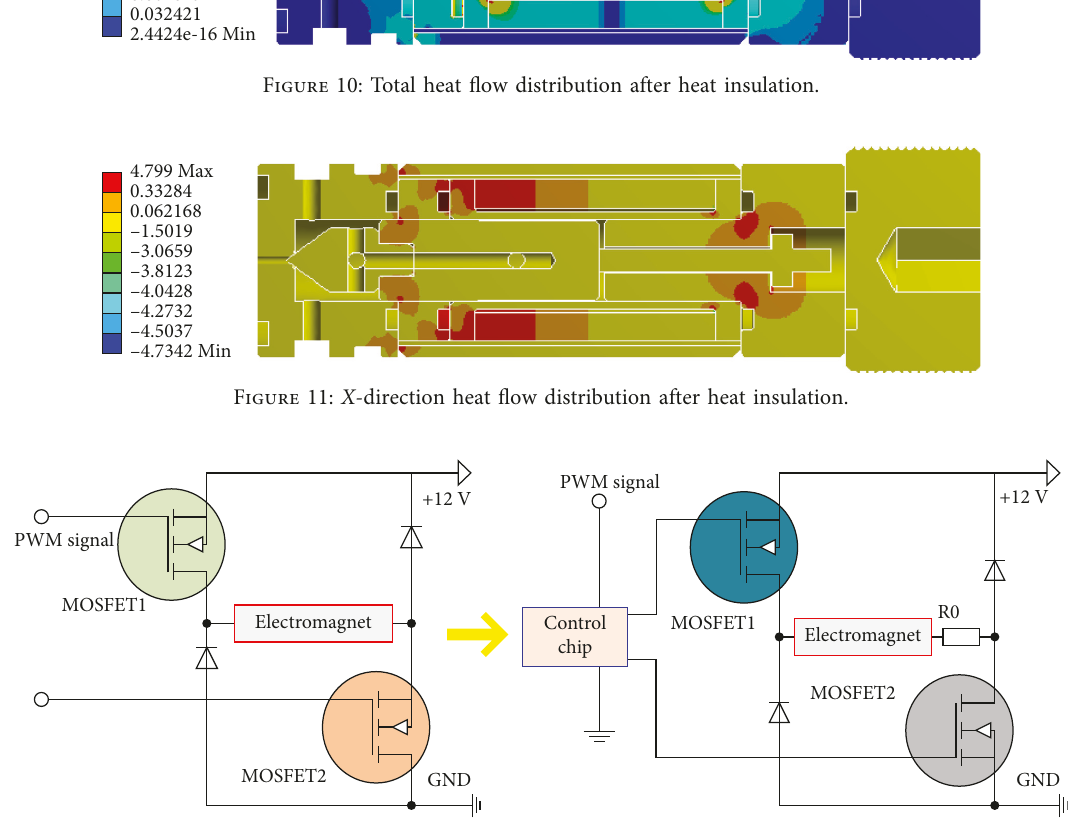
Figure 12: Reverse unloading drive circuit and improvement scheme.